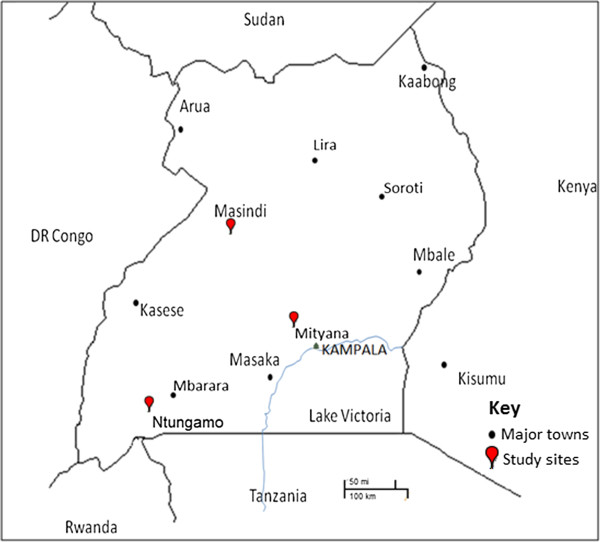
Map of Uganda showing the three study districts (with the red indicator). Major towns in Uganda are also included for further guidance.